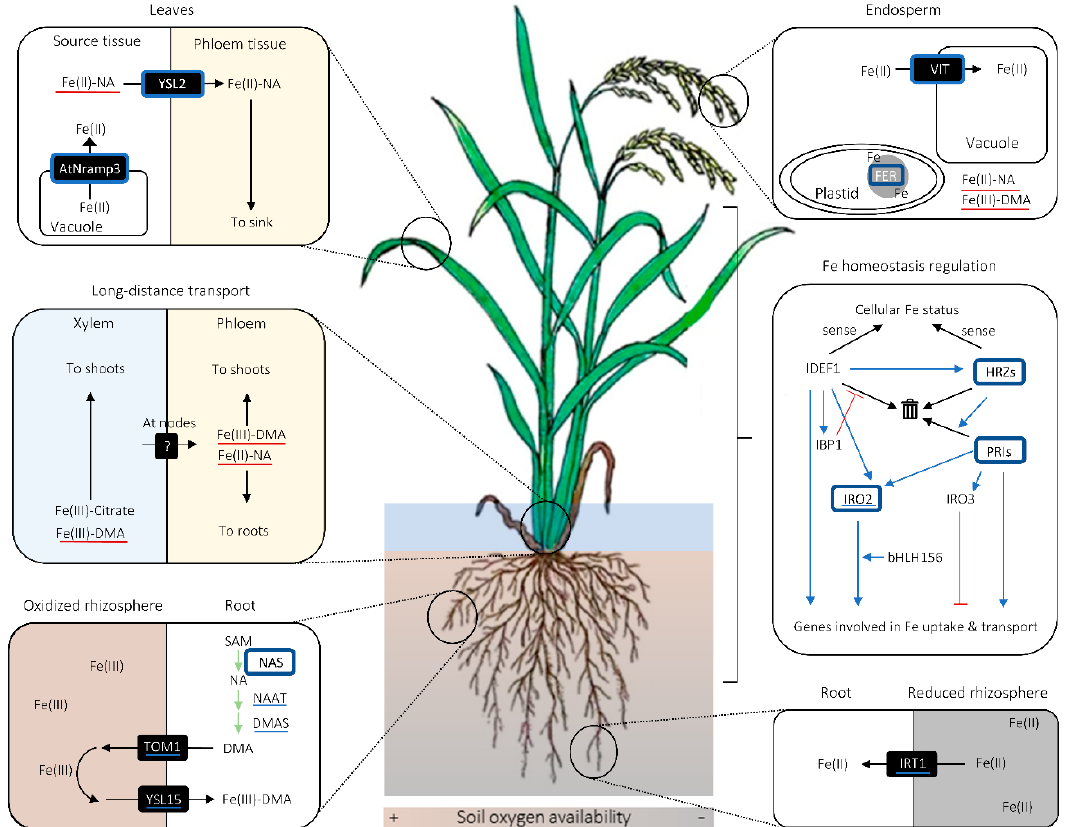
Figure 2. Graphical summary of important cereal iron (Fe) biofortification strategies. Proteins surrounded with blue squares are those whose modulation leads to increase in grain Fe concentration. Blue underlines indicate the molecules whose genes are up-regulated in rice lines overaccumulating nicotianamine (NA) or overexpressing NA SYNTHASE ( NAS ). Red underscores refer to the complexes whose amount is putatively increased in NAS -overexpressing lines. Black arrows indicate the movement of molecules unless otherwise noted, whereas green arrows signify synthetic enzymatic reactions. In the inset for Fe homeostasis regulation, blue arrows and red bars with flat ends indicate promotional and suppressive e ff ects between molecular agents and / or processes, respectively. In the same inset, black arrows pointing to the bin indicate proteasomic degradation of proteins. Abbreviations are as follows: AtNRAMP3: NATURAL RESISTANCE-ASSOCIATED MACROPHAGE PROTEIN 3 from Arabidopsis thaliana ; bHLH156: BASIC HELIX-LOOP-HELIX 156; DMA: deoxymugineic